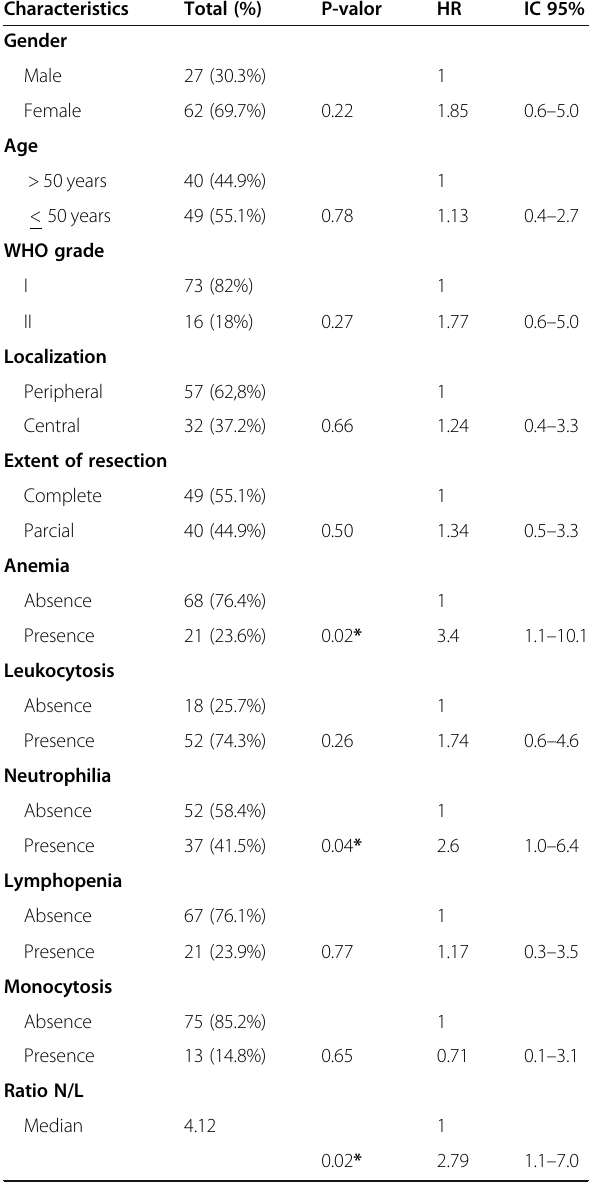
Table 1 Univariate analysis of clinical, tumor and hematological characteristics